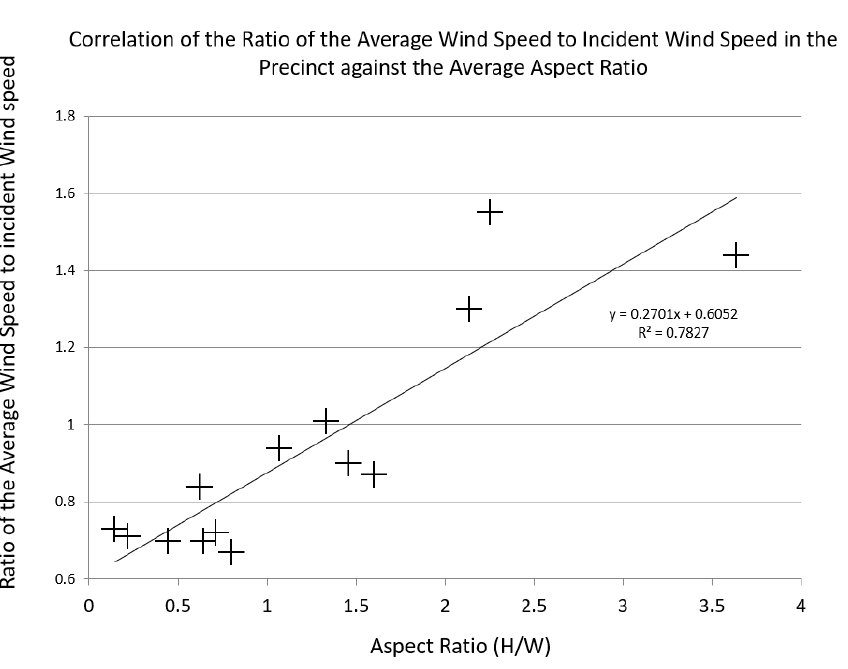
Figure 11. Correlation of the Ratio of the Average Wind Speed to Incident Wind Speed in the Precinct against the Average Aspect Ratio.